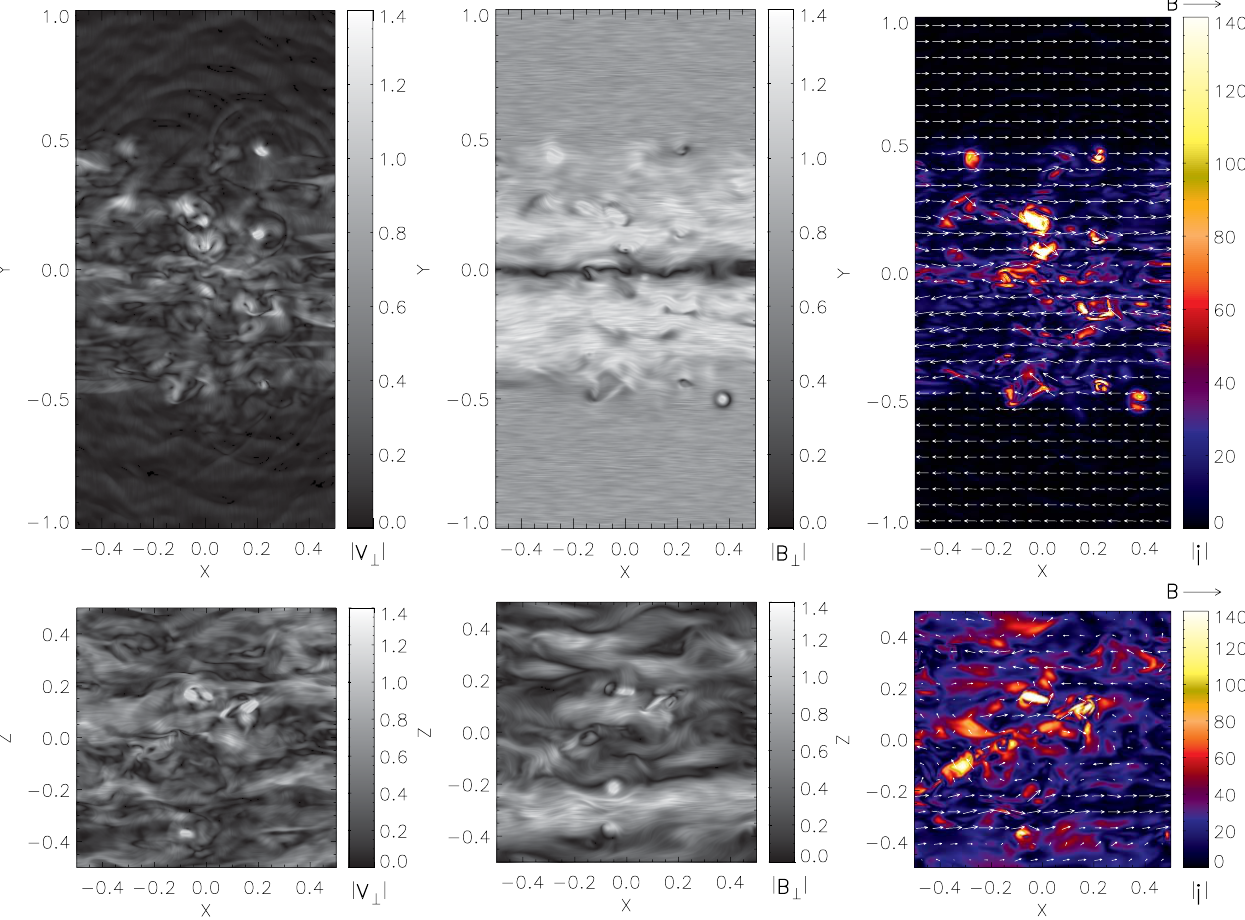
Fig. 6. Topology and strength of the velocity field (left panel) and magnetic field (middle panel) in the presence of fully developed turbulence for an example model with new driving at time t = 10. In the right panel, we show distribution of the absolute value of current density | J | overlapped with the magnetic vectors. The images show the XY-cut (upper row) and XZ-cut (lower row) of the domain at the midplane of the computational box. Turbulence is injected with power P inj = 1 at scale k inj = 8 directly in the magnetic